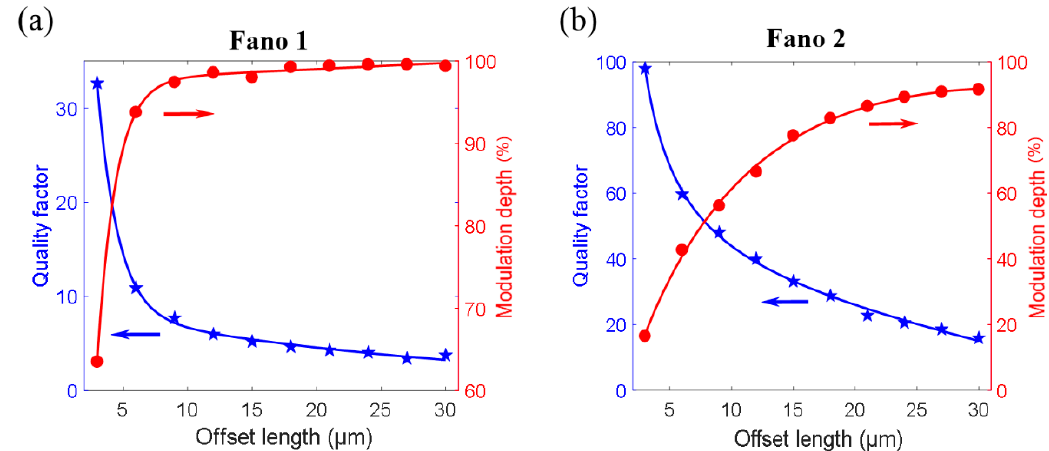
Figure 7. Q-factor and modulation depth of the two Fano resonances for the varying asymmetric parameter (offset length) of the VO 2 -implanted MM structures at high temperature (70 °C): ( a ) Fano 1 and ( b ) Fano 2.